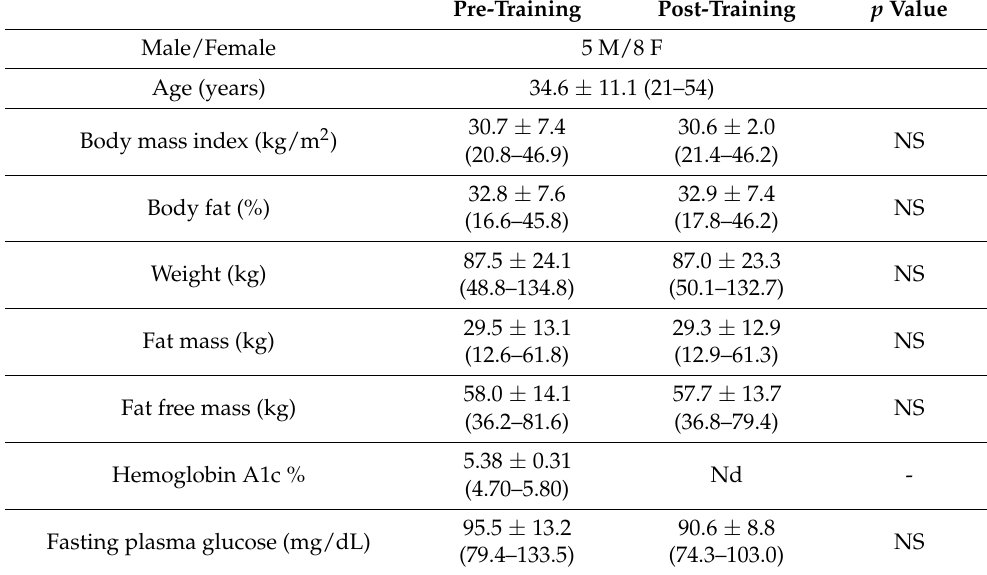
Table 1. Characteristics of volunteers who participated in the